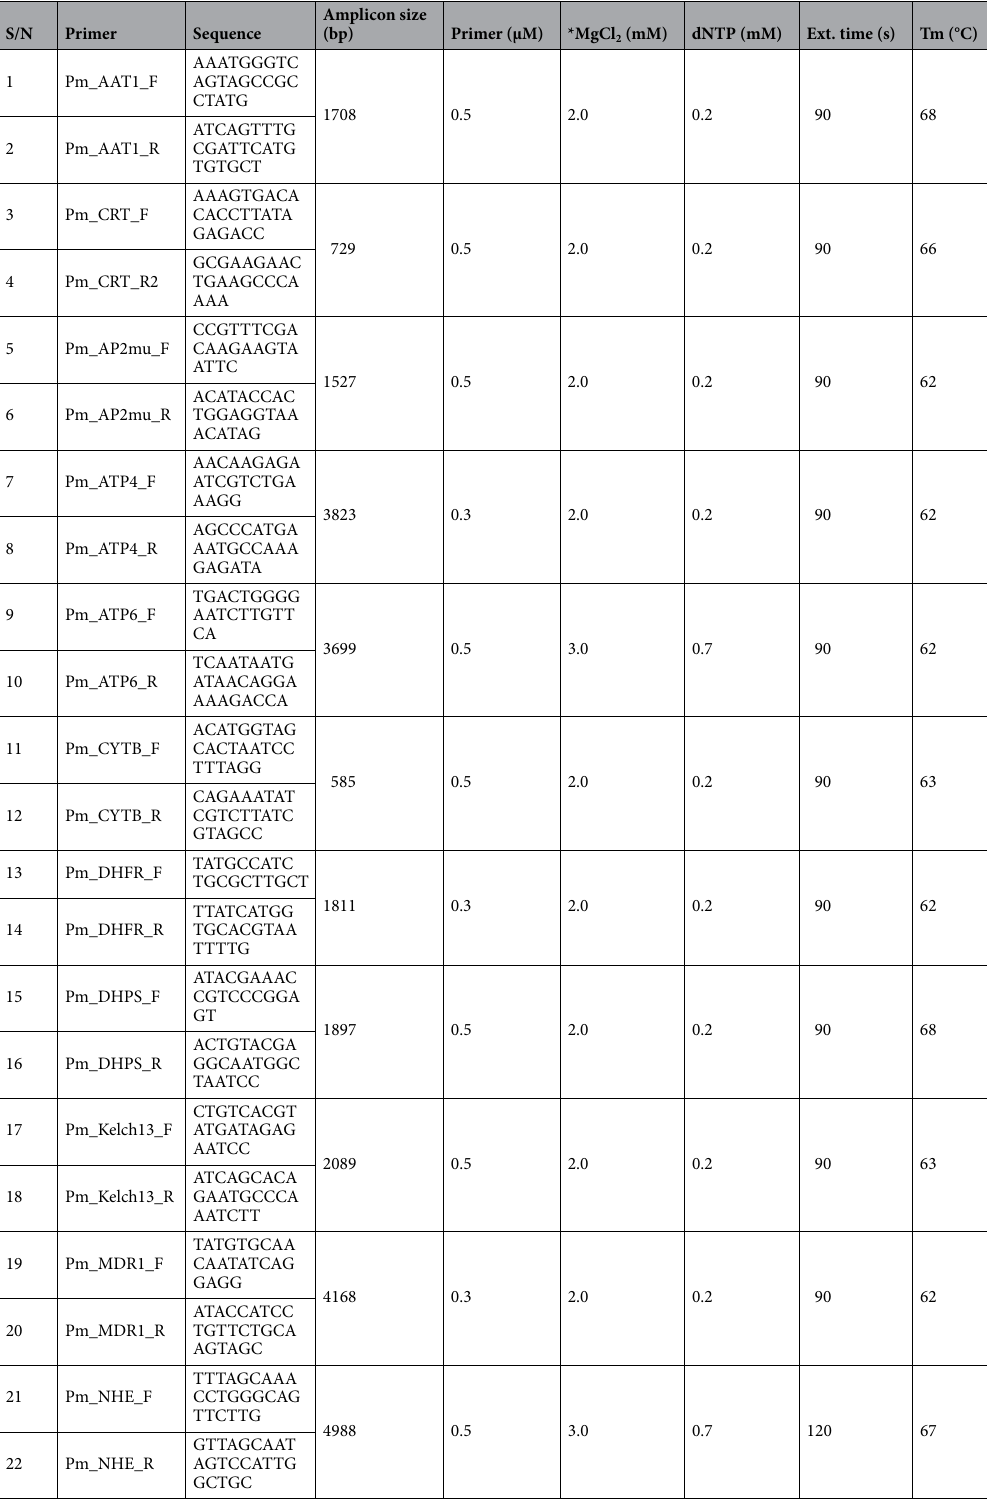
Table 3. Optimized conditions for generating the P. malariae drug resistance amplicons. *Q5 Polymerase buffer has 2.0 mM MgCl 2